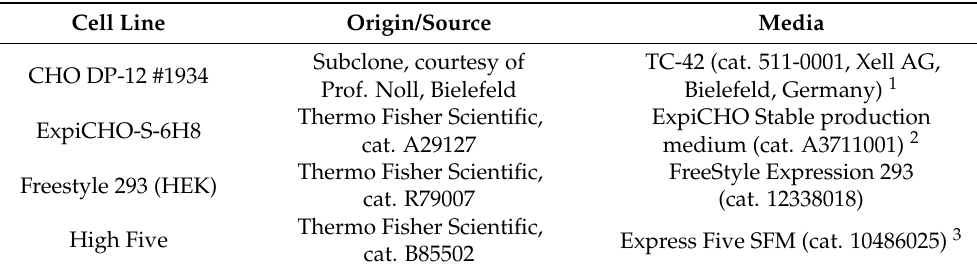
Table 5. Overview of the cell lines (with origin or ordering number) and media (all serum-free or chemically